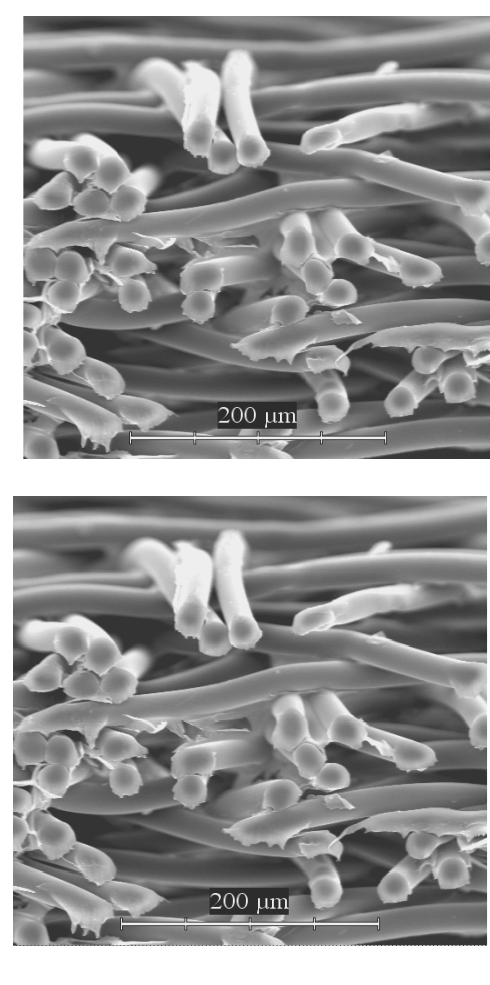
Figure 5: SEM images of polypropylene nonwoven (A) and polypropylene nonwoven coated with chitosan (B).